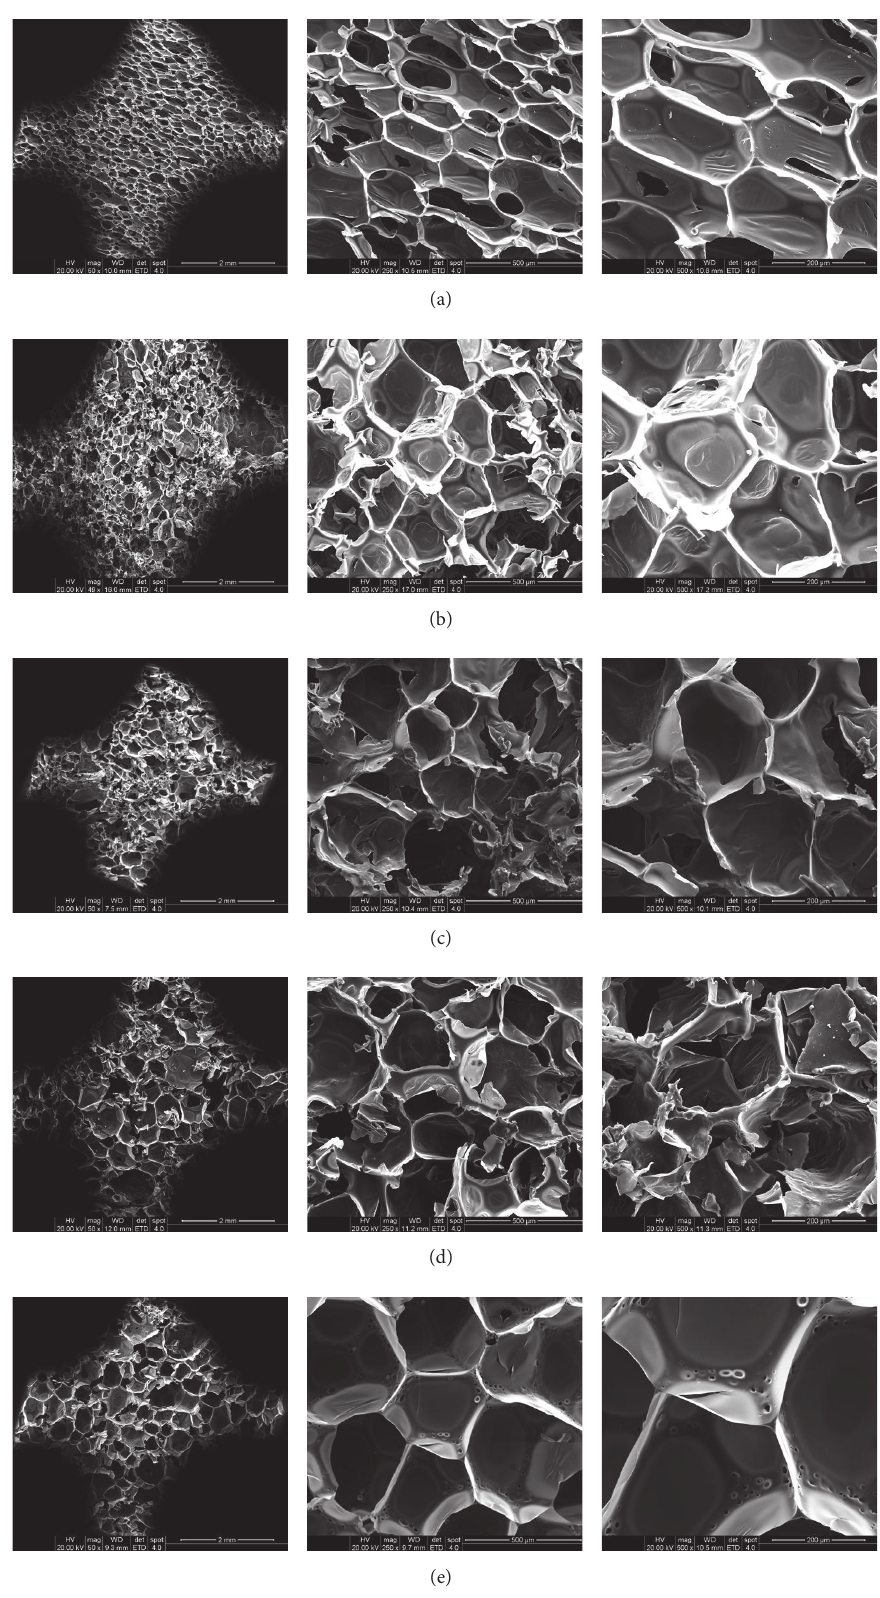
Figure 5: SEM photos of MFCG samples ((a) 10%, (b) 30%, (c) 50%, (d) 80%, and (e)